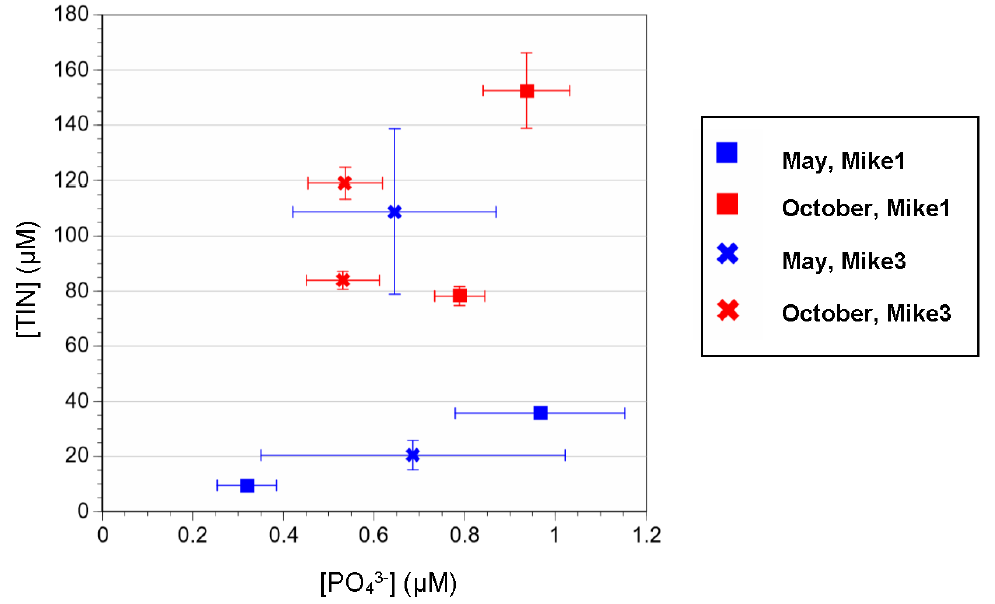
Figure 11. Soluble reactive phosphorus (SRP, PO 43 − ) and total inorganic nitrogen (TIN) concentrations ( μ M) in porewater at the Mike1 (square) and Mike3 (cross) locations during May (blue) and October (red) 2015; standard error bars are present in both the x and y dimensions.